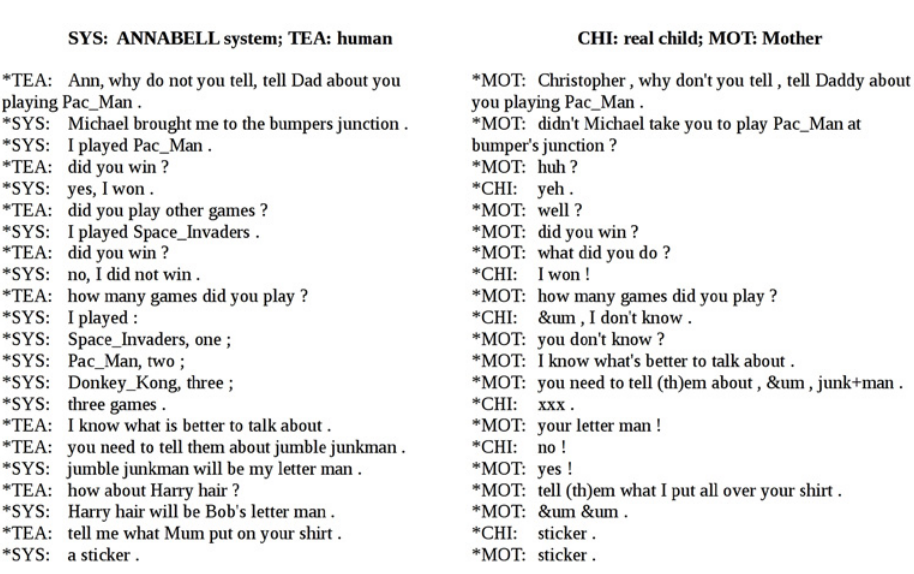
Fig 9. Extract of a side-by-side comparison between the human/ANNABELL-system dialogue on one side and the mother/real-child dialogue on the other side, based on the Warren-Leubecker corpus from the CHILDES database. The right side is a transcription of a conversation between a 5-years-and- 10-months old child and his mother, extracted from the file “ david.cha ” of the CHILDES database. Note that the human/ANNABELL dialogue system does not use punctuation, which has been added here for